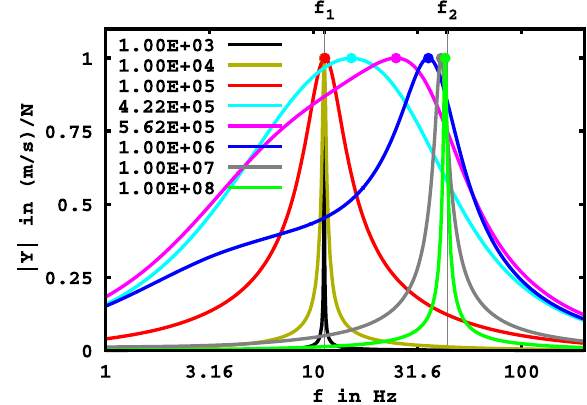
Figure 3. Magnitude of the admittance at the point of excitation. Comparison between Kraak ’ s and own calculations, using open and closed outer boundary conditions according to (50) and (51) respectively.